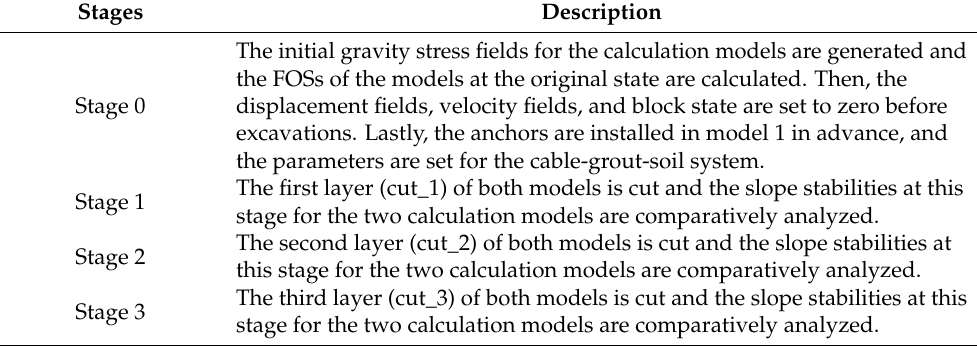
Table 2. Physical and mechanical parameters of the semi-solid hard clay slope.